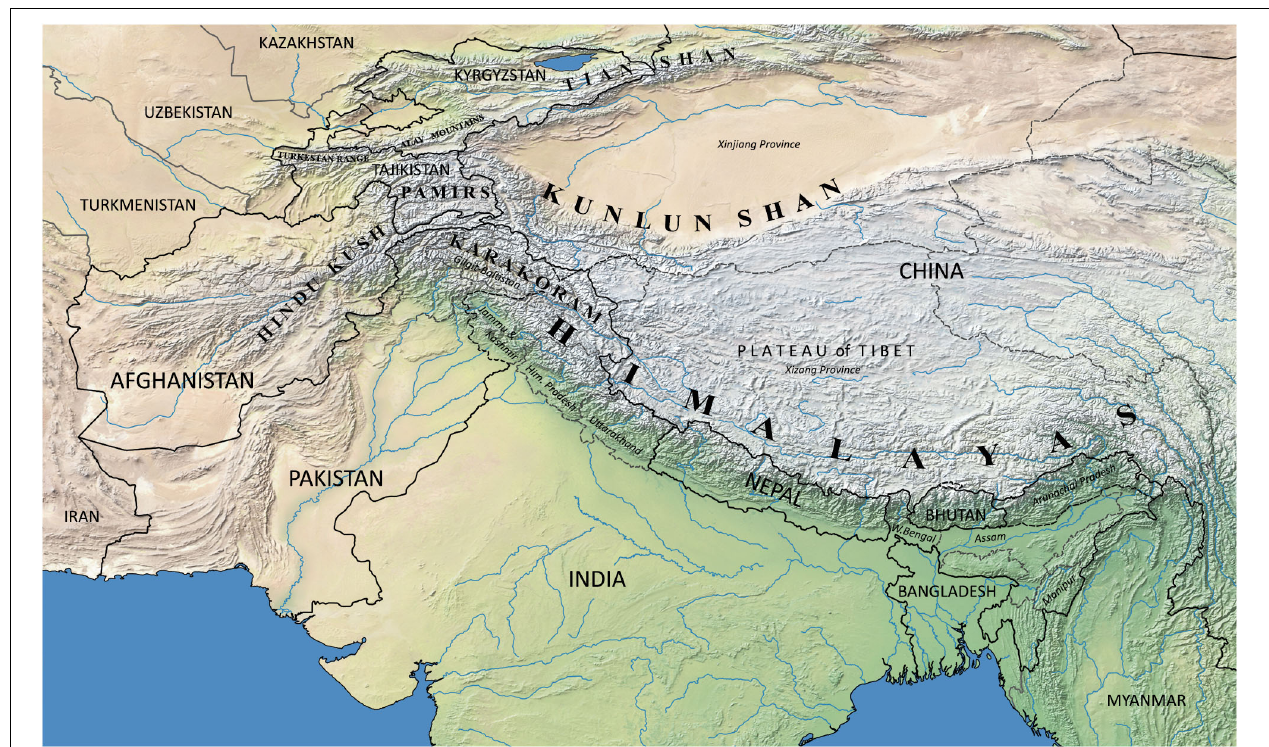
FIGURE 2 | Main mountain ranges of the South and Central Asian regions (original source: Natural Earth raster + vector map).